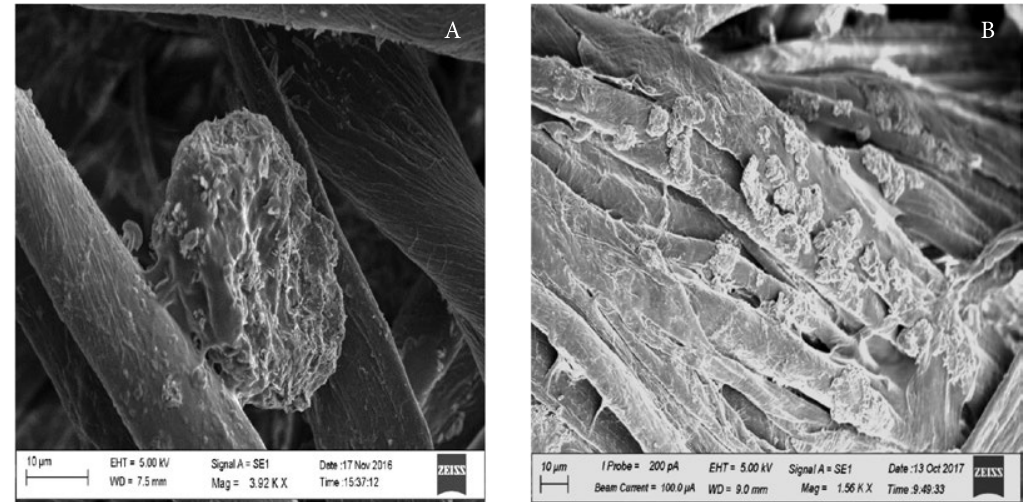
Figure 8. A – SEM images of lime oil microcapsule incorporated textile before washing (× 3.92 K magnification) B– SEM images of lime oil mi- crocapsules incorporated textile before washing (× 1.56 K